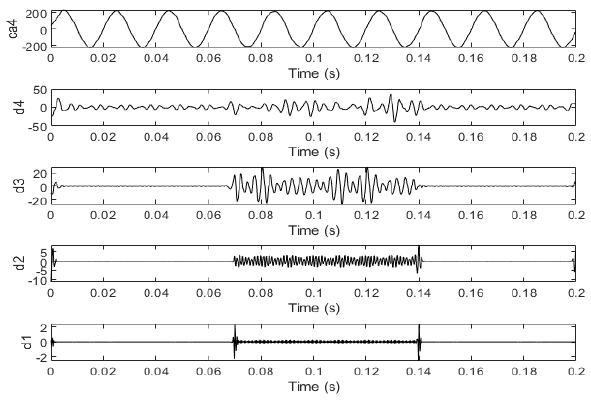
Figure 26. Figure 26. Harmonic. Figure 26. Harmonic. Figure 26. Harmonic.